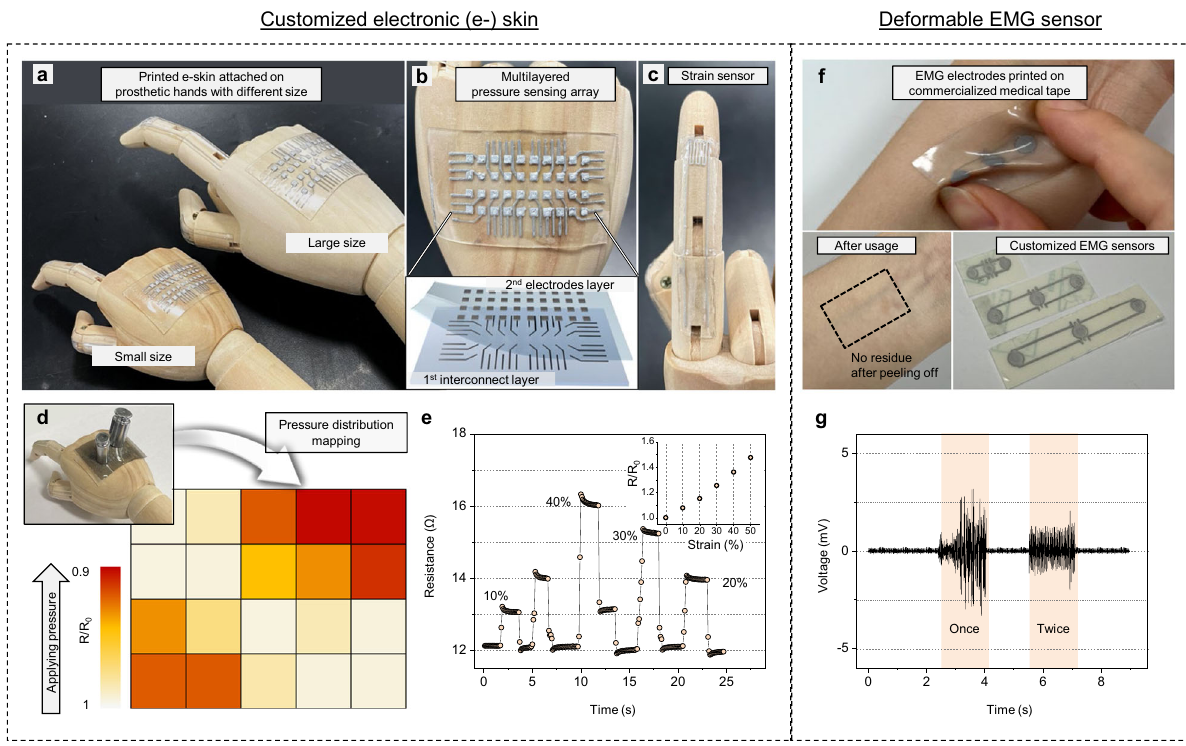
Fig. 6 PaLMP-based customizable e-skin and deformable EMG sensor. a Photograph of PaLMP-based customized e-skin attached to prosthetic hands with different sizes. b Photograph and illustration of multilayer pressure sensing array. c Photograph of strain sensor. d Pressure distribution mapping with multilayer pressure sensing array. e Real-time resistance monitoring with strain sensor. Inset: relative resistance according to strain ( f ) Photograph of deformable PaLMP-based EMG sensor fabricated on the commercialized medical tape. No residue is observable after detaching the EMG sensor from the skin. g EMG signals measured with PaLMP-based EMG sensor on